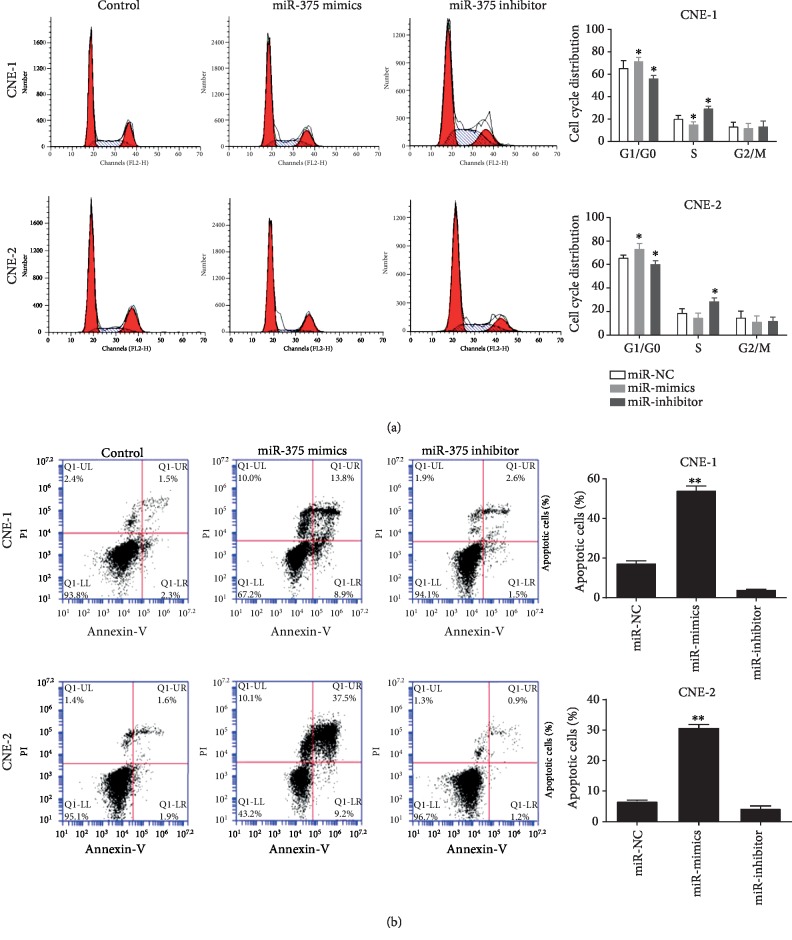
The expression of miR-375 accelerated progression through the cell cycle and increased apoptosis in NPC cells. (a) Flow cytometry was carried out to evaluate cell cycle progression in CNE-1 and CNE-2 cells transfected with miR-375 mimic or inhibitor. (b) Annexin V-FITC/PI staining was carried out to measure the extent of apoptosis among CNE-1 and CNE-2 cells transfected with miR-375 mimic or suppressor. Data are shown as mean ± SD. Each experiment was repeated three times (∗P < 0.05 and ∗∗P < 0.01 vs. scramble group).